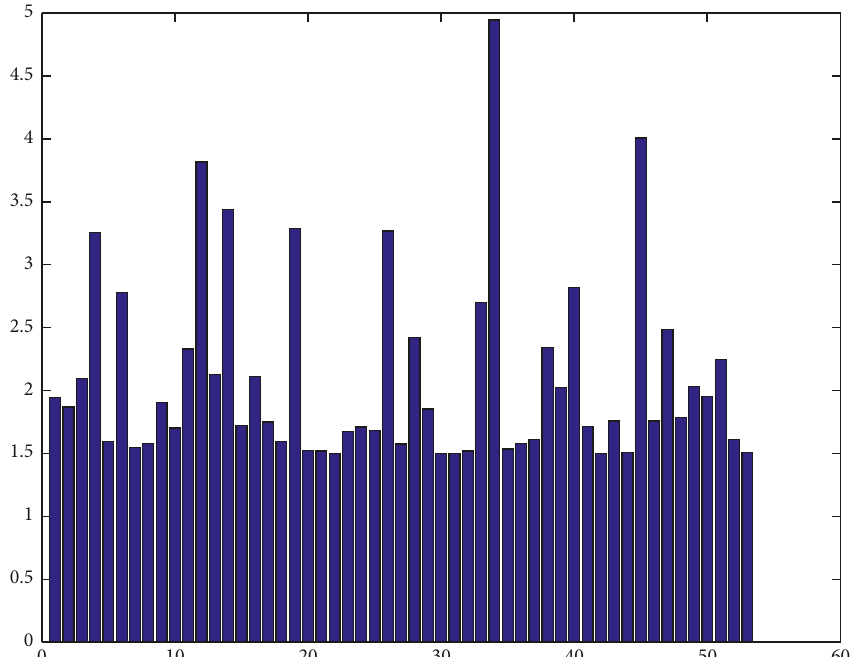
s ) of storms in the period 2009–2014 measured at